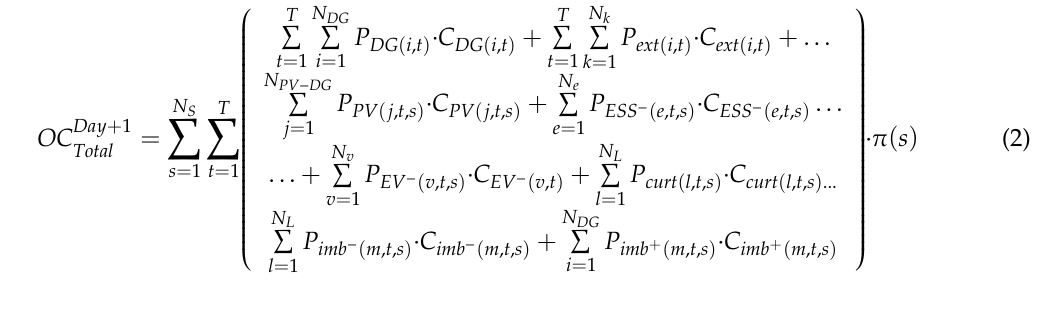
Table 3. Specifications of SMG